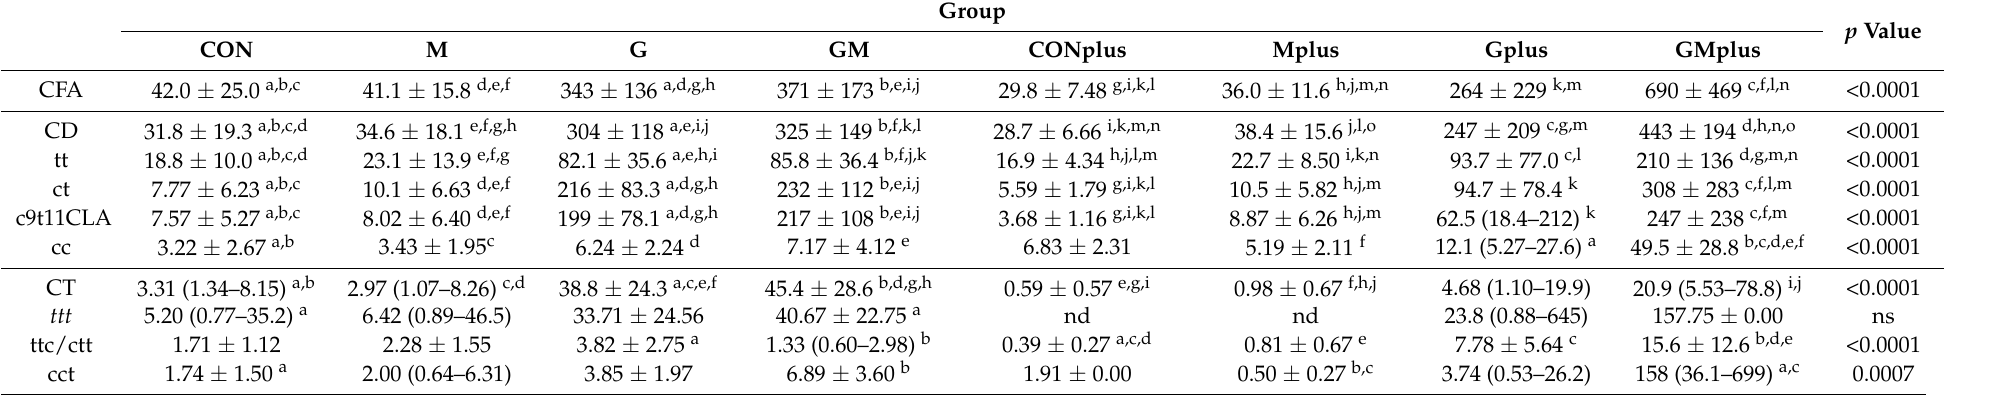
Table 2. Contents of geometrical CFA isomers in hepatic microsomes of experimental groups ( µ g/g of fat).